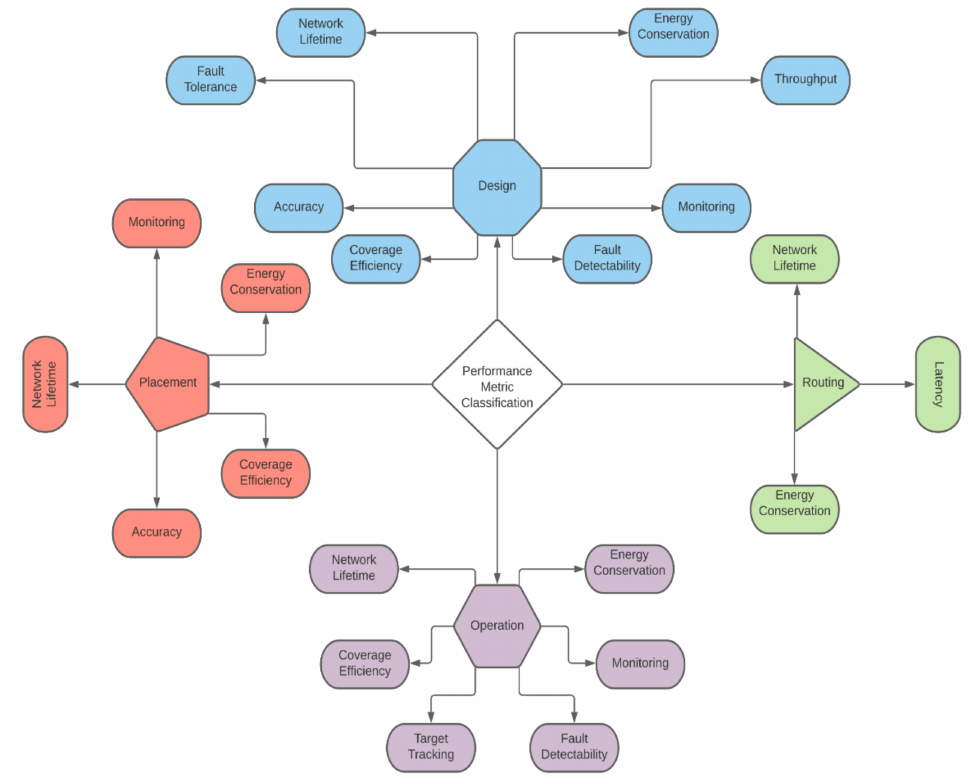
Figure 1. Classification of Objectives for